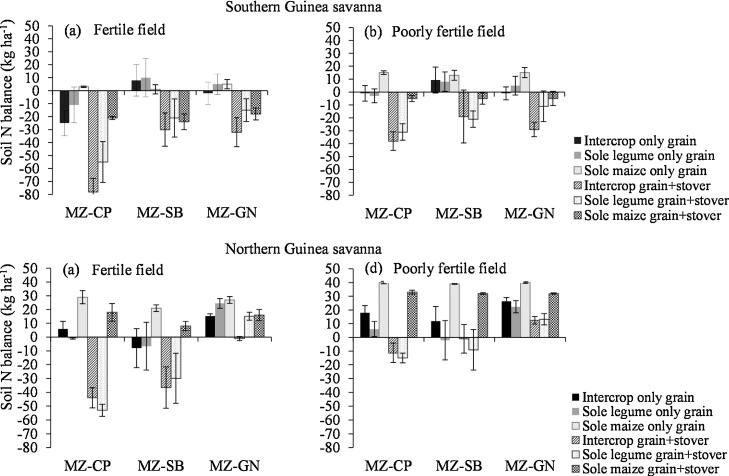
Soil N balance as influenced by different cropping systems in (a) a fertile field in SGS, (b) a poorly fertile field in SGS, (c) a fertile field in NGS and (d) a poorly fertile field in NGS of northern Ghana with grain only or both grain and stover exported. The soil N balance of intercrops combines both maize and legumes. The error bars represent the standard errors of means.